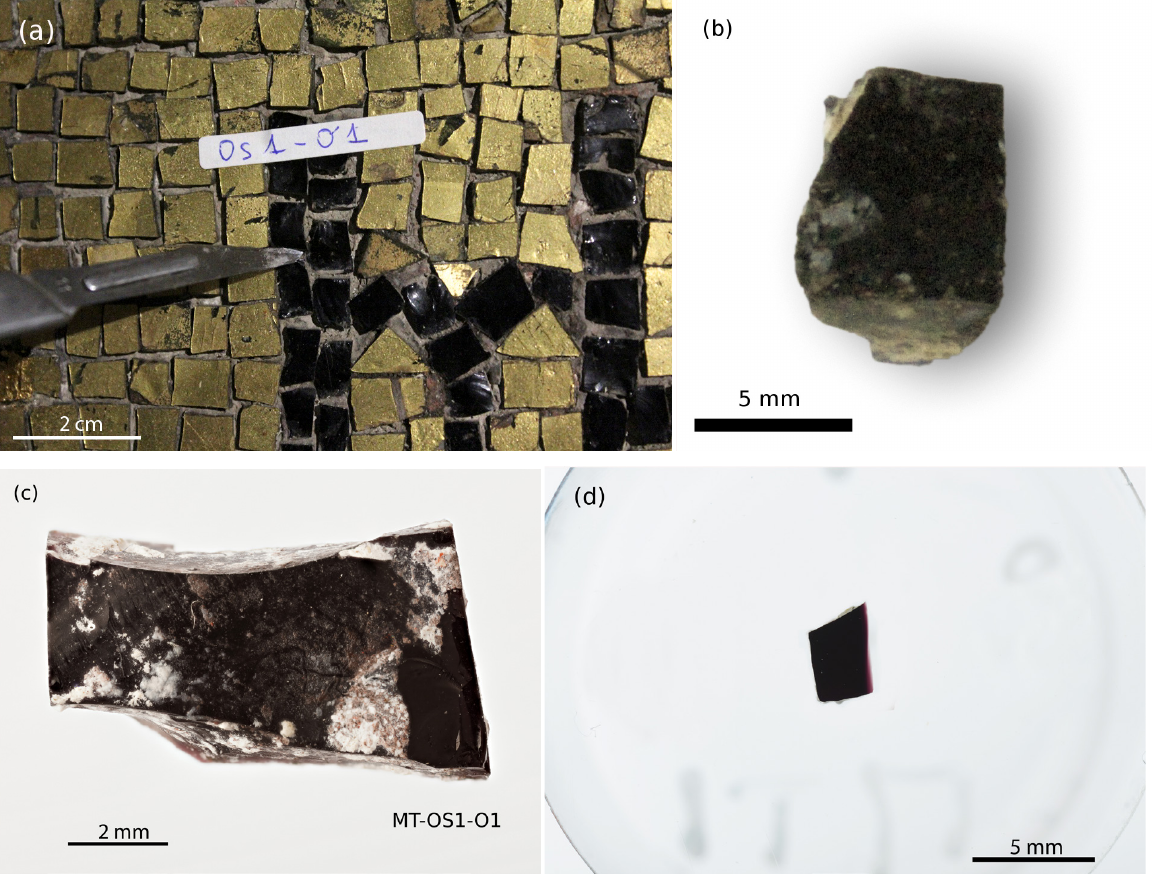
Figure 7: Palermo, St. Mary of the Admiral, Dedication panel: (a) Photo of the sampling area, with the position of the black tesseraselected for the archaeometric analyses; (b) photo of the whole black-appearing tessera detached from the panel (a–b: photos V. Cantone); (c) photo of the sampleMT-OS1-O1, cut from the back of the tessera for the archaeometric analyses; (d) photo of the polished resin block including a part of the sample MT-OS1-O1. (c–d: photos S.